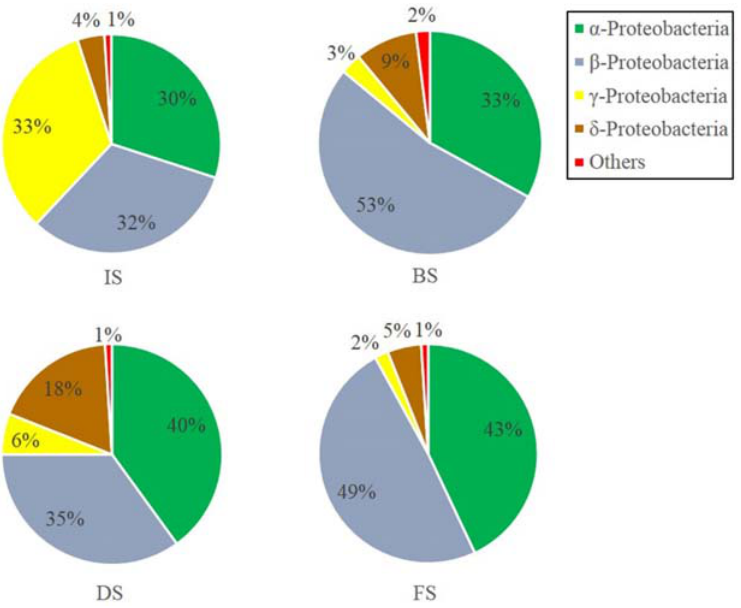
Figure 9. Class compositions of Proteobacteria in four stages of the MLCOP reactor.